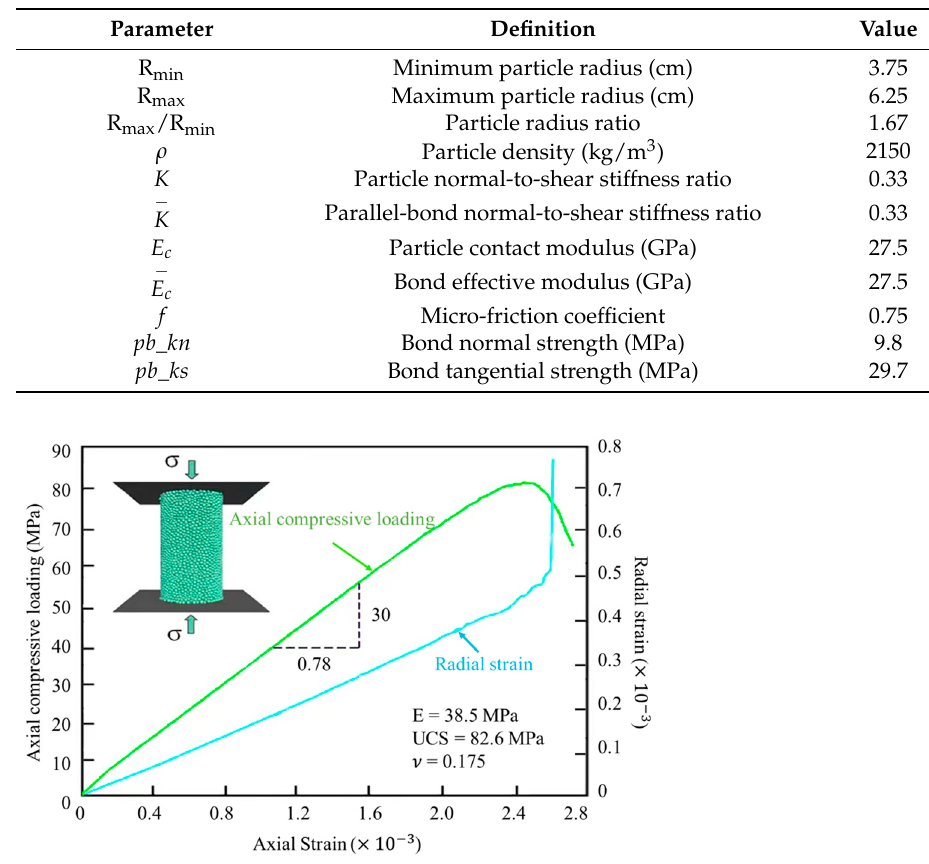
Table 1. Micro-strength parameters of the PFC 3D model.